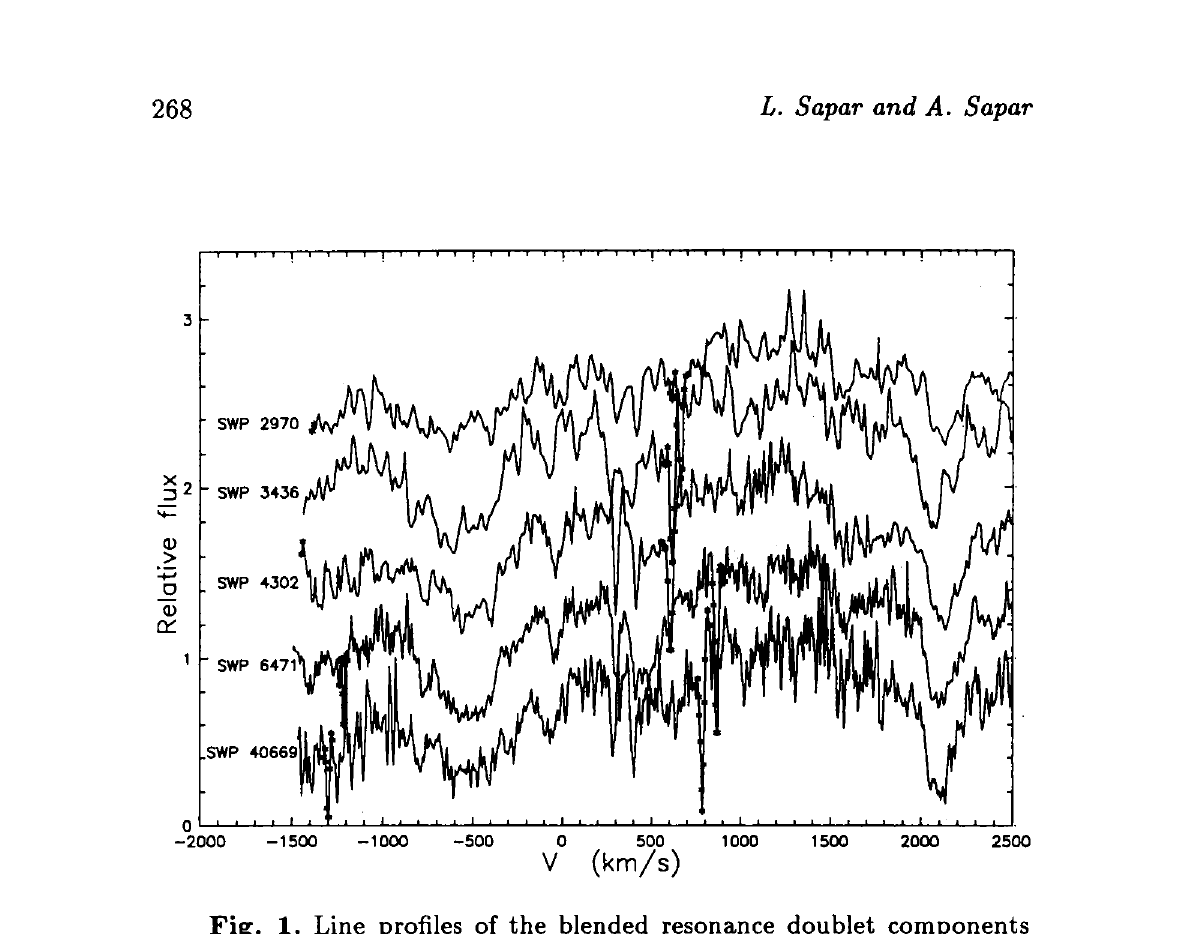
Fig. 1. Line profiles of the blended resonance doublet components NV A 1238.81 A and A 1242.50 A with a shifted continuum level. For the doublet components, cAA/A fa 950 km/s. Although the signal to noise ratio is low, it is evident that there are considerable changes in line profiles. The changes demonstrate that the overionization degree of NIV is variable probably due to small variations in temperature which are well visible in the Wien spectral region. The weak red wing shows that the extension of NV region of stellar wind is small. The reseau-contaminated and overexposed points are marked by